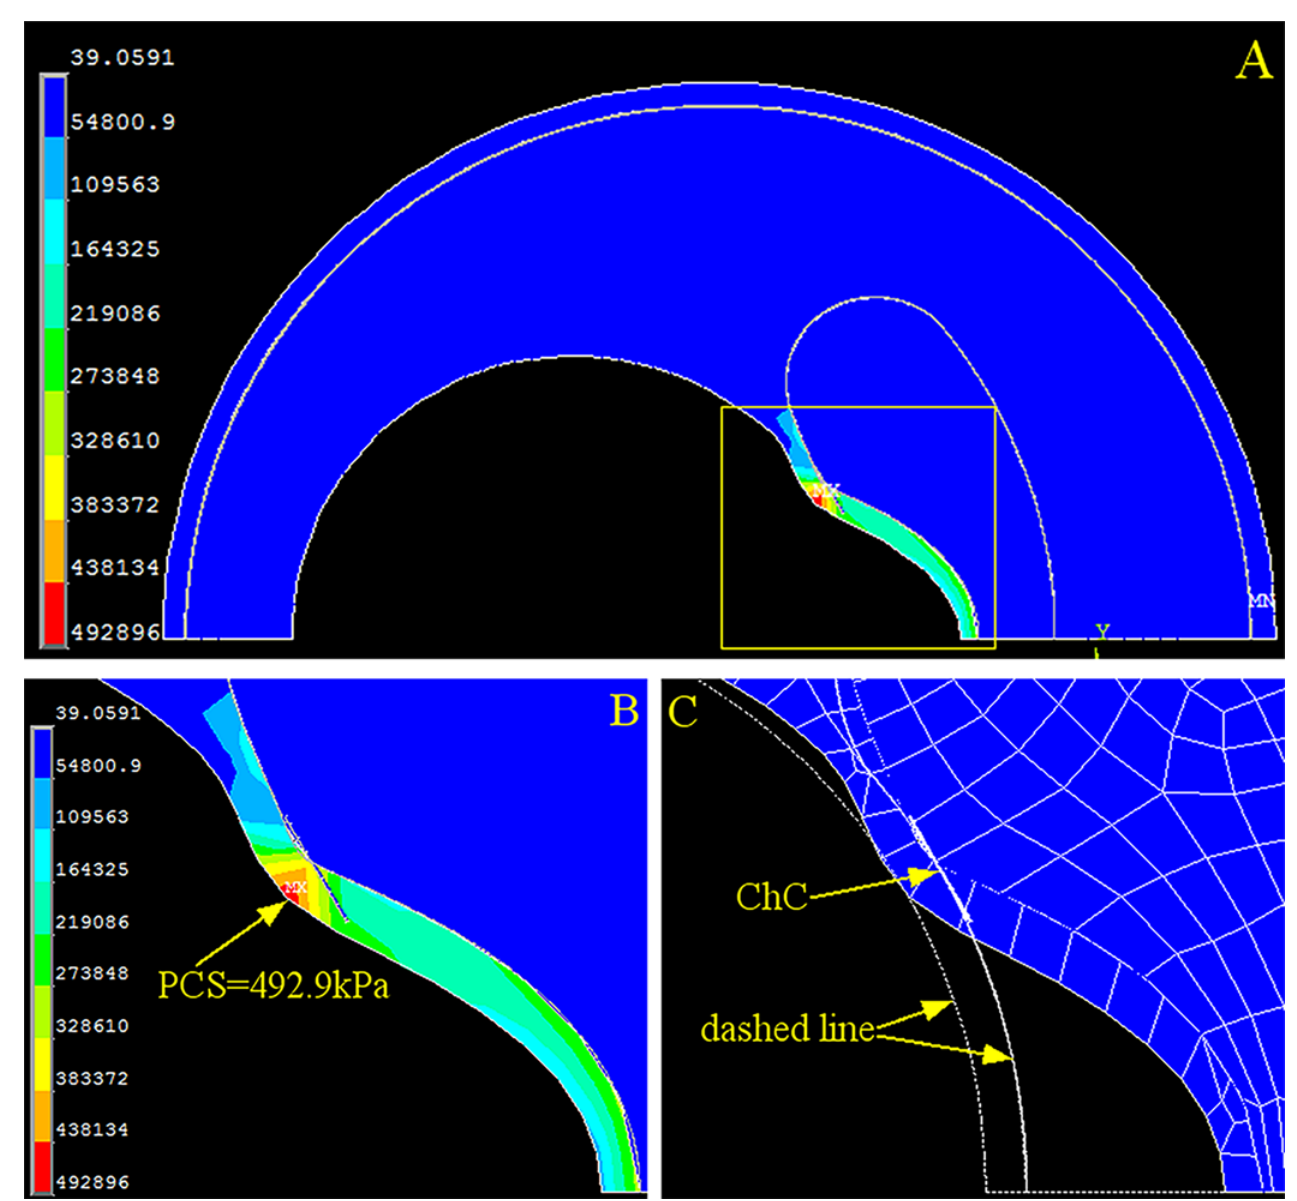
Fig 5. Stress and Strain of the Artery with One Cholesterol Crystal at the Cap Shoulder. (A) Stress distribution of the overall coronary artery. (B) Contour plot of the stress on the fibrous cap (yellow dashed box in A). (C) Contour plot of the strain on the fibrous cap. The dashed line is the original contour before loading, and the meshed section is the deformed cap after loading. PCS: peak circumferential stress. ChC: cholesterol